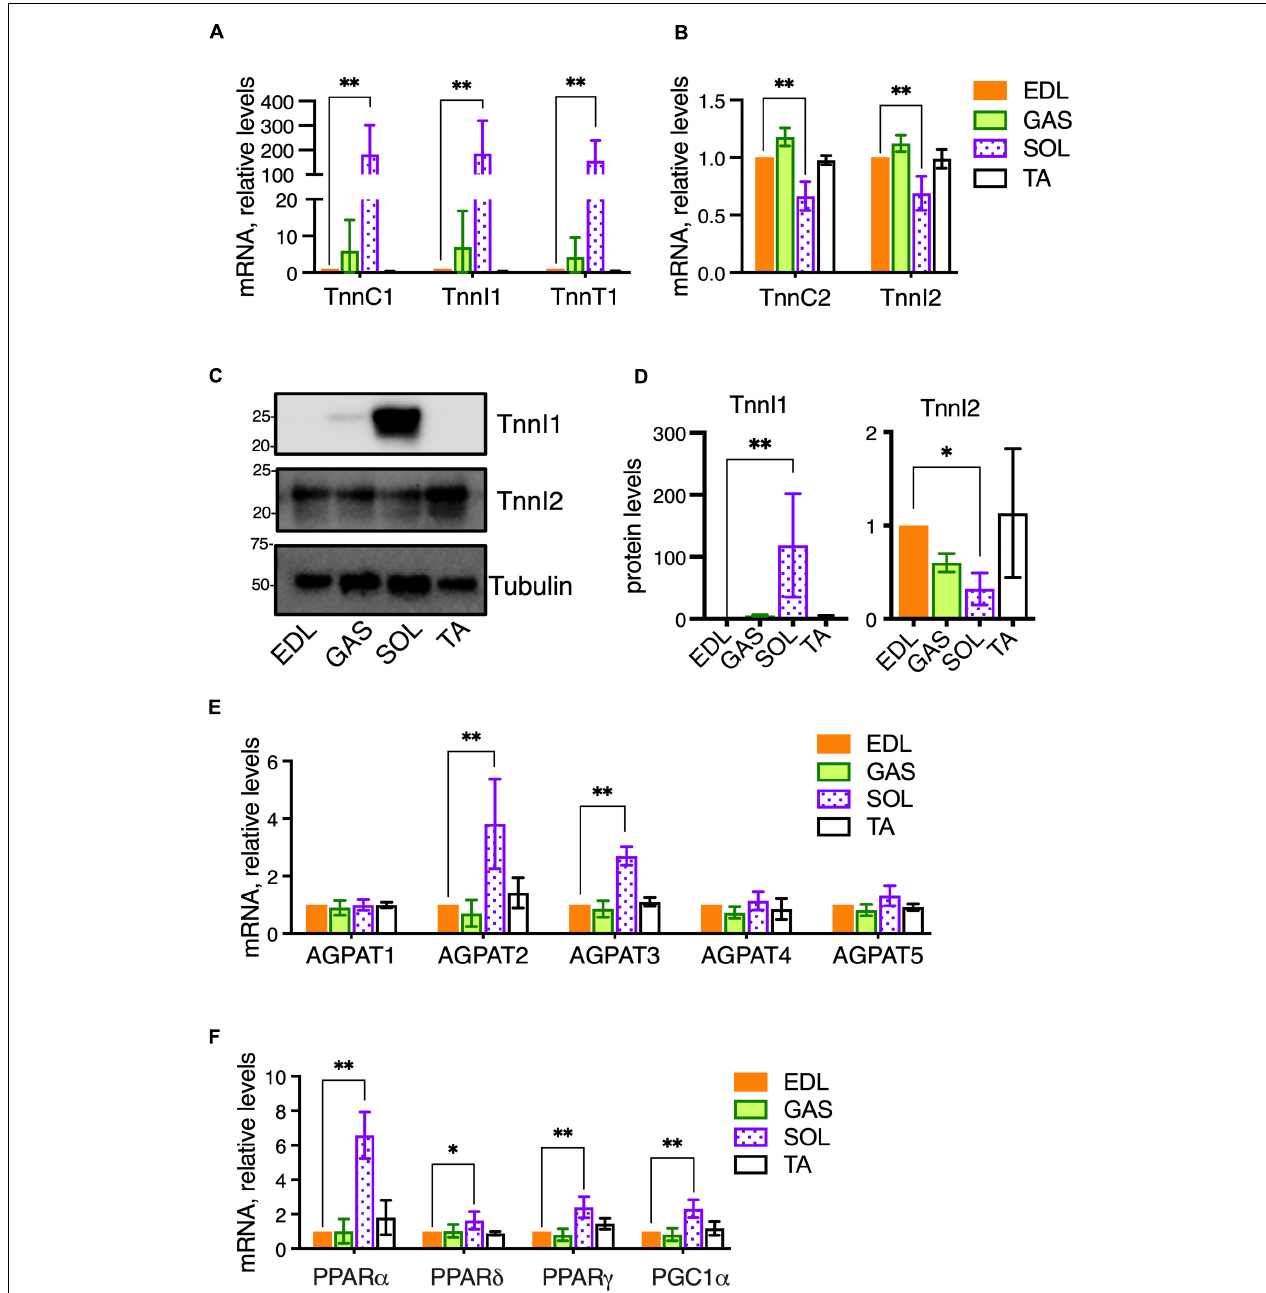
FIGURE 2 | Metabolic gene expressions in healthy skeletal muscles of adult (14–16-week-old) C57BL/6 mice raised on CE-2 standard chow. mRNA levels were measured by qPCR and protein levels (for TnnI1 and TnnI2) were detected by Western blotting. EDL was selected as a “standard” muscle to determine the statistical variations, and the plotted values reflect relative abundances compared to the levels in EDL (arbitrarily set to “1”). Compared to EDL, SOL had markedly high levels of slow-type troponins TnnC1, TnnI1, and TnnT1 (A) and moderately decreased fast-type troponins TnnC2 and TnnI2 (B) . Similar patterns in SOL were observed for the protein levels of TnnI1 (high levels) and TnnI2 (moderately decreased) (C,D) . mRNA levels of AGPATs (E) and PPARs/PGC1-alpha transcriptional regulators (F) were also determined. mRNA levels were normalized to 18S RNA and protein levels were normalized to Tubulin. The means ± SD are plotted. Statistical significance is based on Dunnett’s multiple comparison tests. ∗ p < 0.05, ∗∗ p < 0.01; n = 4